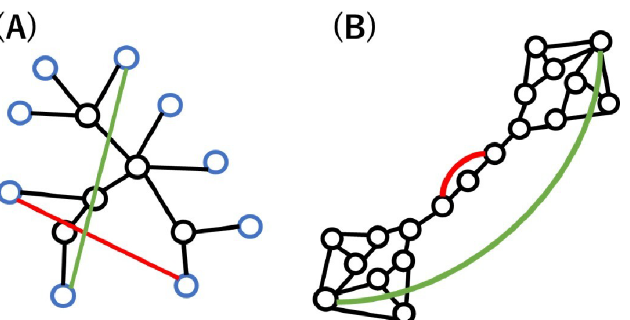
Fig 1. Added links on the minimum degree and longest distance strategies. (A) The minimum degree and longest distance strategies select similar nodes on a tree, while (B) these strategies select different nodes on a network with loops. Red and green links show added links on the minimum degree and longest distance strategies. Blue nodes are leaf